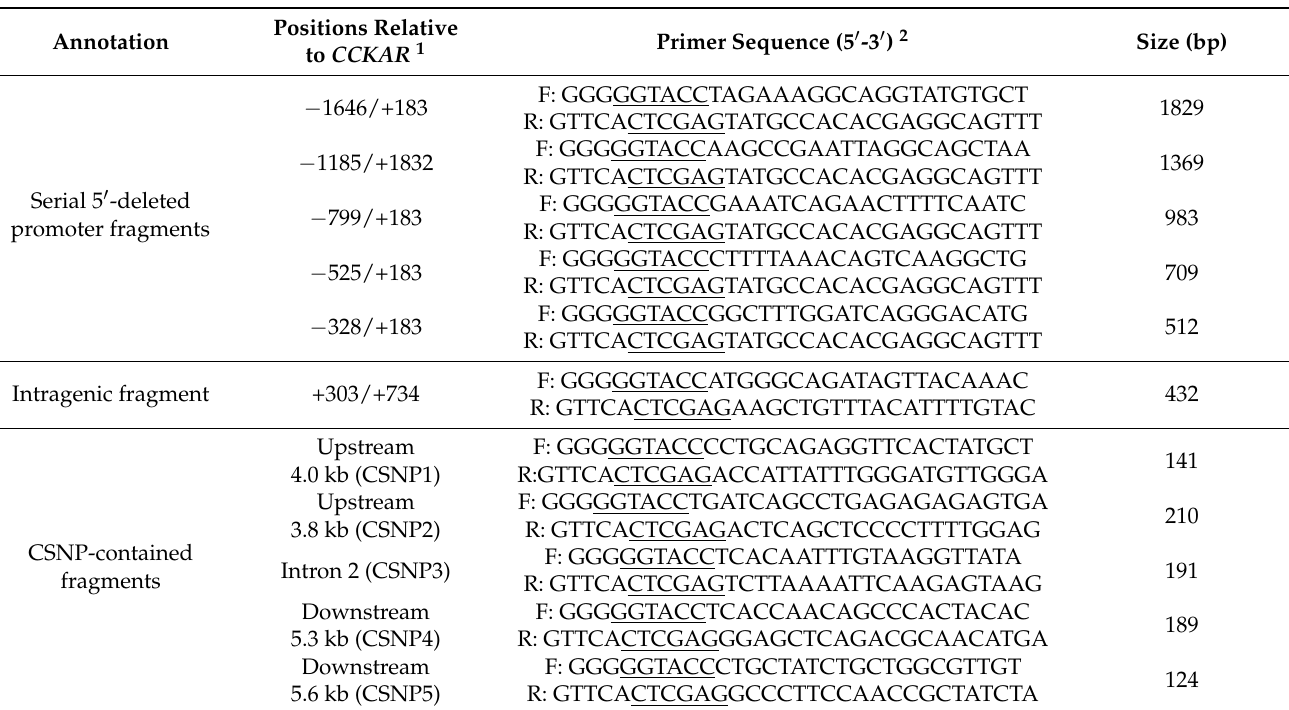
Table 1. Annotations of promoter and conserved regions analyzed in the reporter assay, and primers for PCR amplification of target